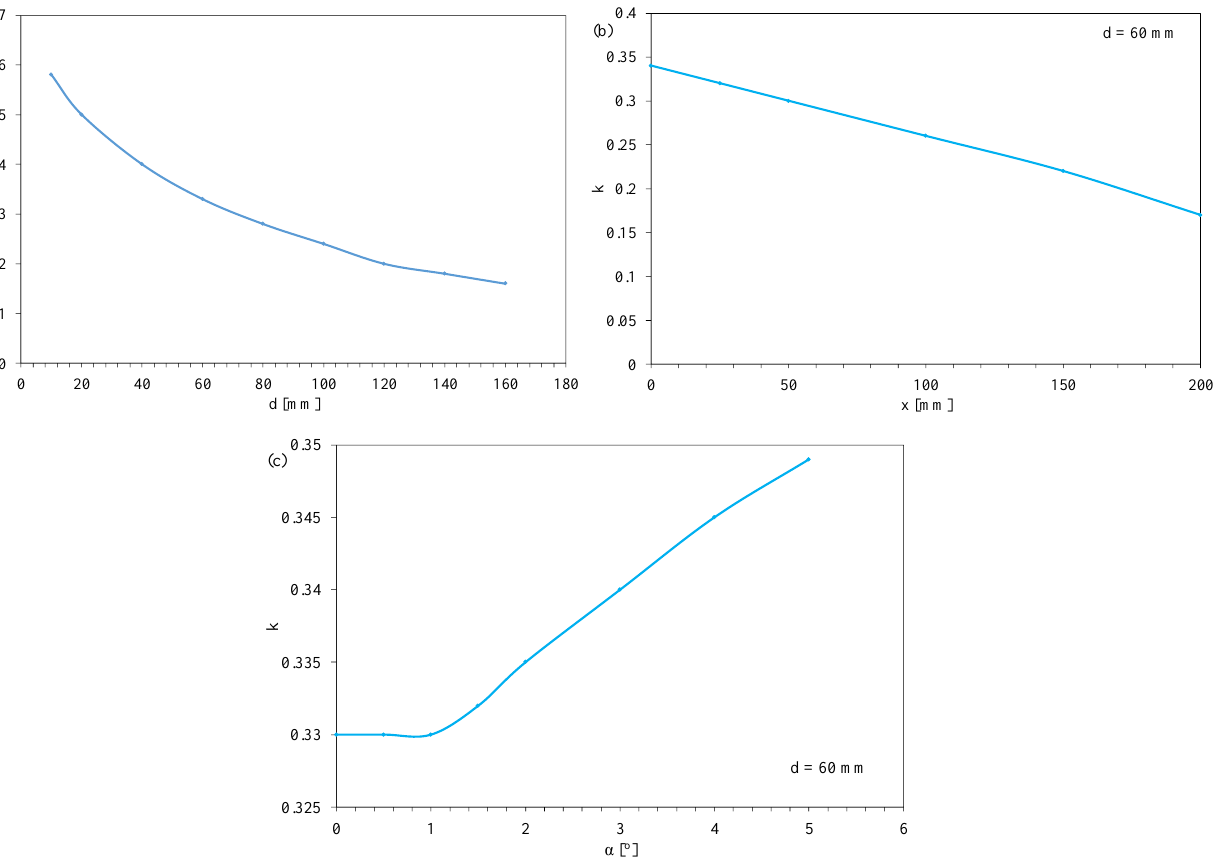
Figure 5. Influence of changing the horizontal position ( a ), vertical position ( b ), and the angle ( c ) of the transmitting and receiving coils with a rectangular cross-section on the coupling factor.